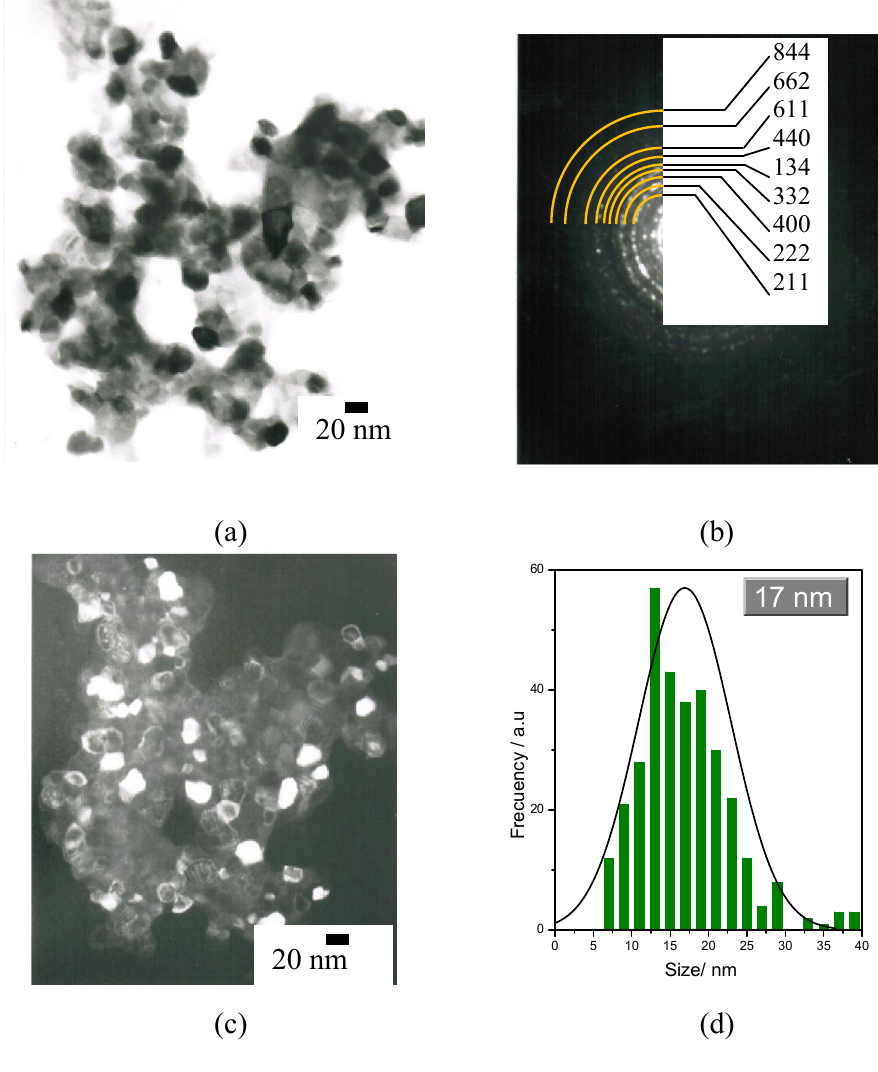
O 5 mol %Eu 3+ , 0.01 mol % Tb 2 3